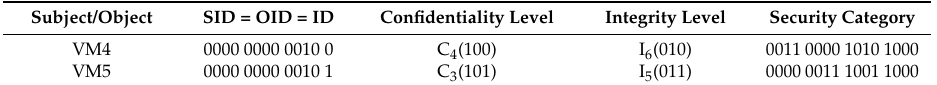
Table 7. Security settings of VM4 and VM5.